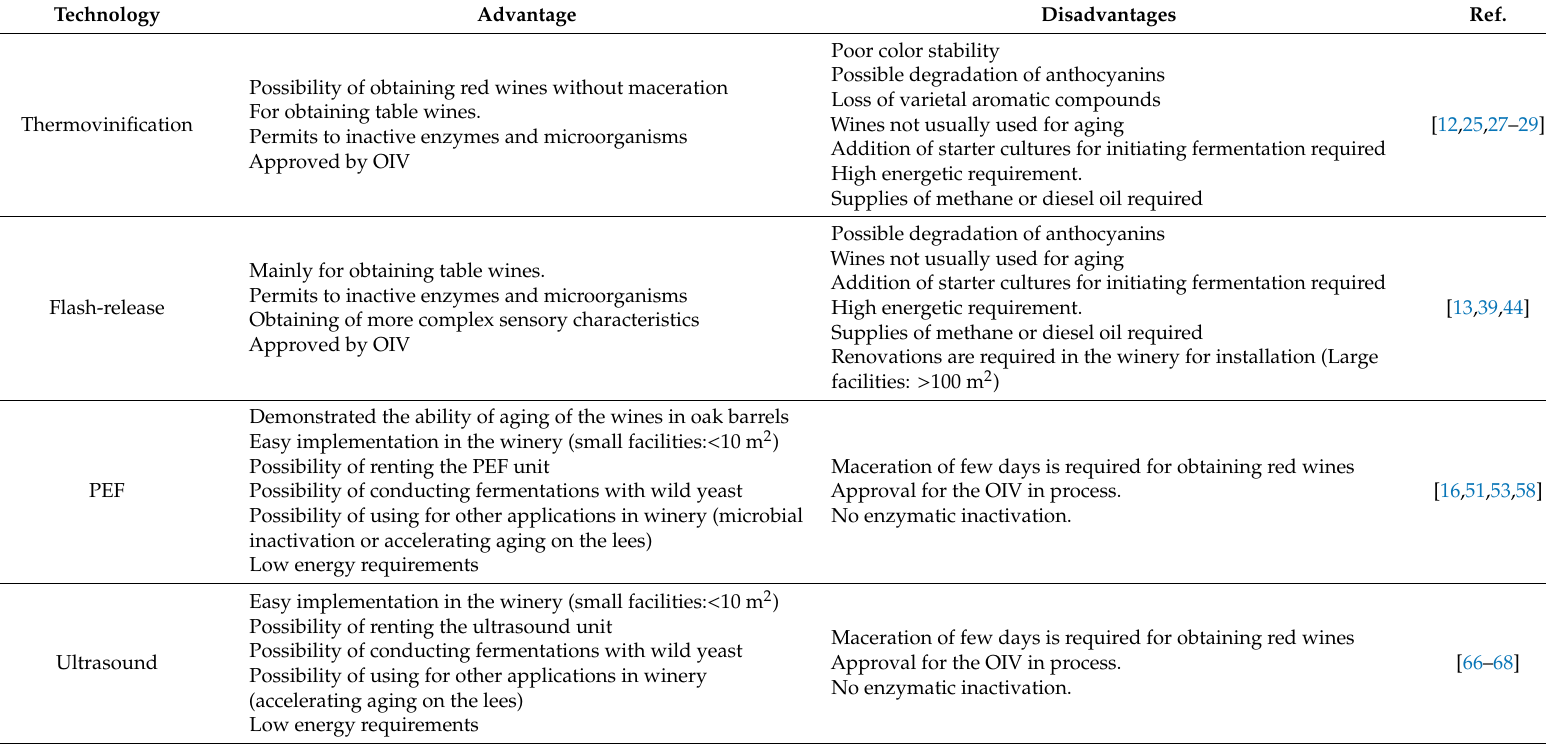
Table 2. Advantages and disadvantages of di ff erent thermal and non-thermal technologies for improving polyphenol extraction in red winemaking for grape pre-fermentation